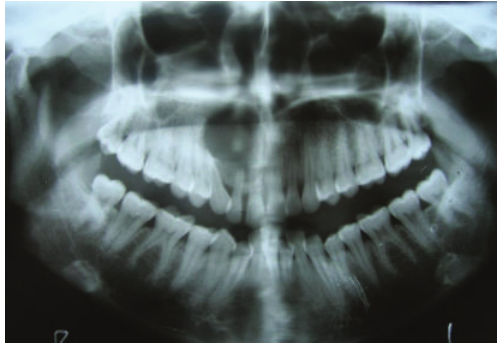
Figure 2: Palatally swelling extending from 11 to 14 regions.